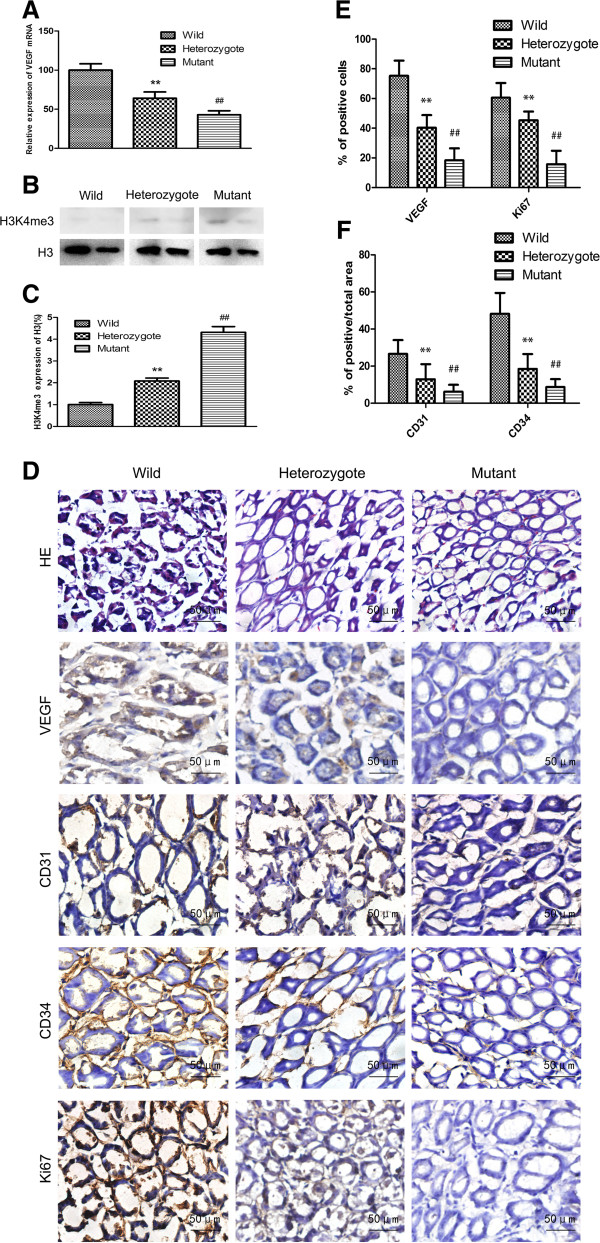
VEGF expression and angiogenesis in RBP2-targeted mutant mice. (A) QRT-PCR analysis of VEGF mRNA in the wild type (the number is 6), heterozygote (4) and mutant mice (3). **P < 0.01 vs wild type group, ##P < 0.01 vs wild type group. (B, C) Trimethylation of H3K4 in wild-type, heterozygote and mutant mice. Two representatives of each group are shown. **P < 0.01 vs wild type group, ##P < 0.01 vs wild type group. (D) Hematoxylin and eosin (HE) staining and immunohistochemical staining of VEGF, CD31, CD34 and Ki67 expression in wild-type (left panel), heterozygote (middle panel) and mutant mice (right panel). Representative images are shown. Percentage positive cells for (E) VEGF and Ki67 and (F) percentage positive staining area for CD31 and CD34 in wild-type, heterozygote and mutant mice determined immunohistochemically. **P < 0.01 vs wild type group, ##P < 0.01 vs wild type group. Data are mean ± SEM of 3 independent experiments.